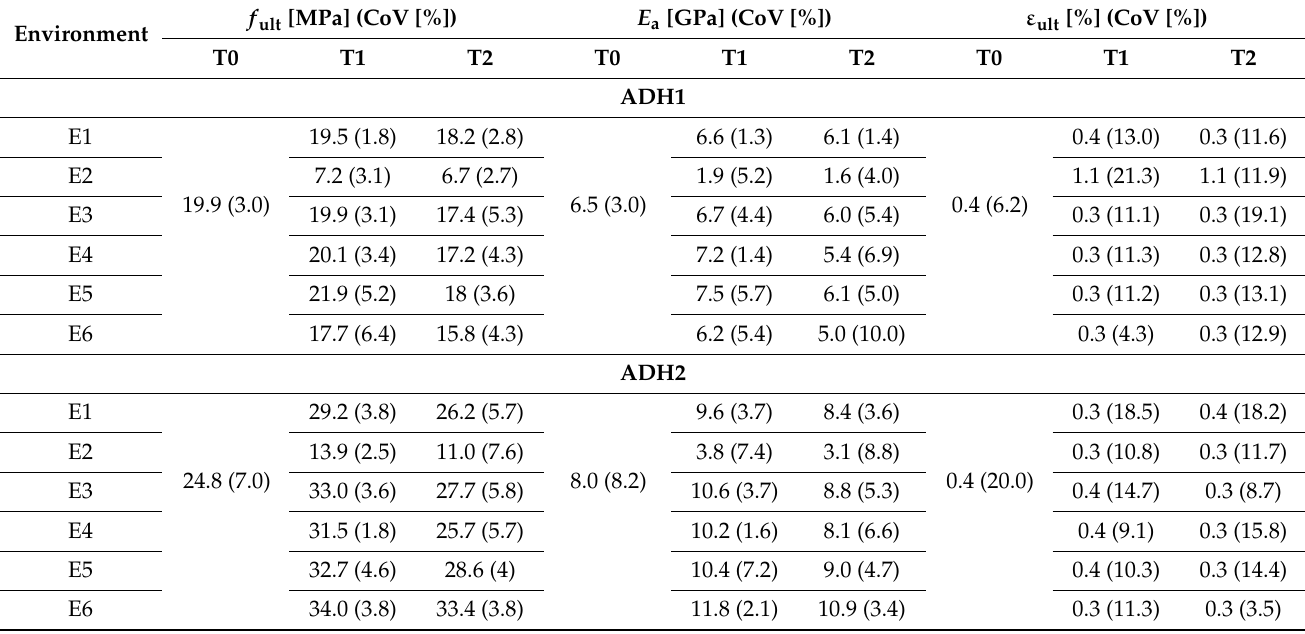
Table 5. Tensile properties of adhesives ADH1 and ADH2, after one (T1) and two (T2) years of exposure to the environment studied (E1 to E6), including the reference